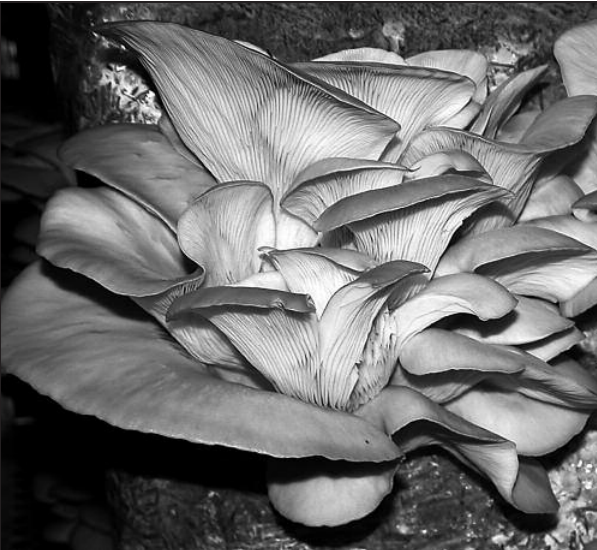
Figure 2. Oyster mushroom ( Pleurotus spp.)